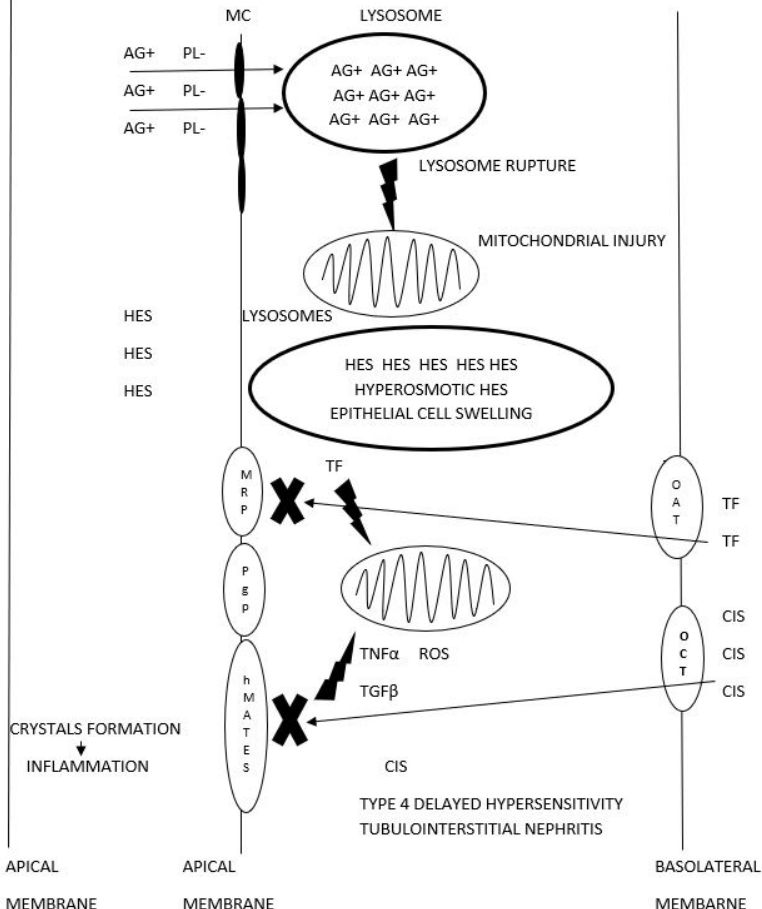
Figure 1. Schematic illustration of drug nephrotoxicity. AG+ aminoglycosides, PL- anionic phos- pholipids, MC megalin-cubilin, HES hydroxyethyl starch, TF tenofovir, CIS cisplatin, OATorganic anion transporter, OCT organic cation transporter, hMATE humanmultidrug, and toxin extrusion protein transporter, MRP multidrug resistance protein transporter, Pgp P-glucoprotein transporter, ROS reactive oxygen species, TGF β transforming growth factor-beta, TNF- α transforming growth factor-beta.